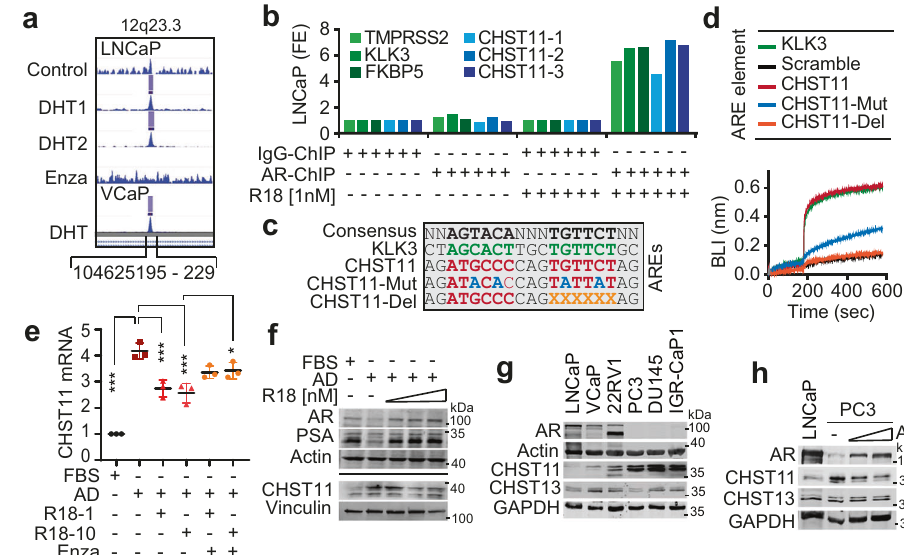
Fig. 3 | CHST11 is an AR repressed gene. a ChIP-seq AR binding intensity within indicated CHST11 genomic region in LNCaP and VCaP cells (Cistrome.com; WashU Epigenome Browser) ( 50 , 51 ). b qPCR analysis using three sets of CHST11 primers designed around the Chr 12:104625188 location, after CHIP of AR in LNCaP cells in CSS media in presence or absence of R1881. TMPRSS2, FKBP5, and PSA validated primers around the ARE were used as positive controls. c Identi fi ed CHST11 ARE, mutated and deleted sequences. d BLI assay where biotinylated AR-DNA binding domain was immobilized sensor and incubated in presence of CHST11 ARE sequences listed in c , KLK3-ARE sequence used as positive control. Representative data of 3 independent experiments. e Levels of CHST11 transcripts by q-PCR in LNCaP cells after 72h of androgen deprivation (AD) condition and 48h of treat- ment with R1881 and/or Enzalutamide normalized to FBS condition. n =3